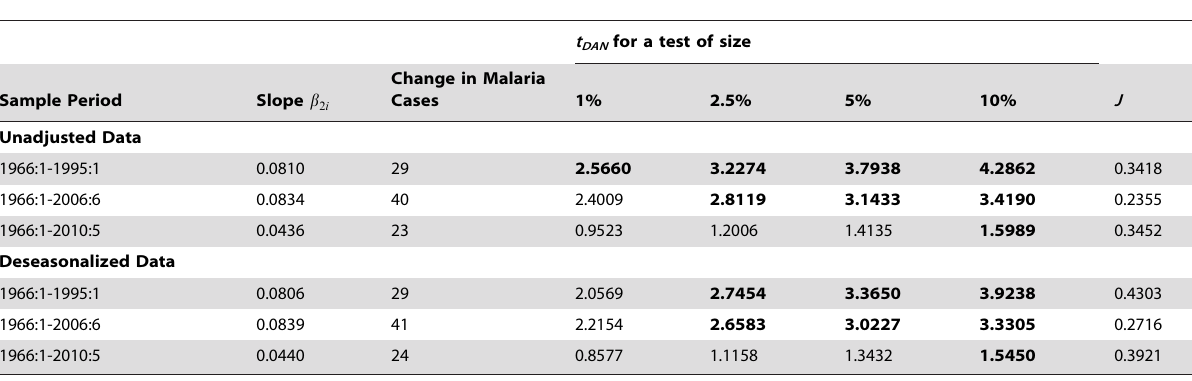
Table 4. Robust Trend Tests for Malaria